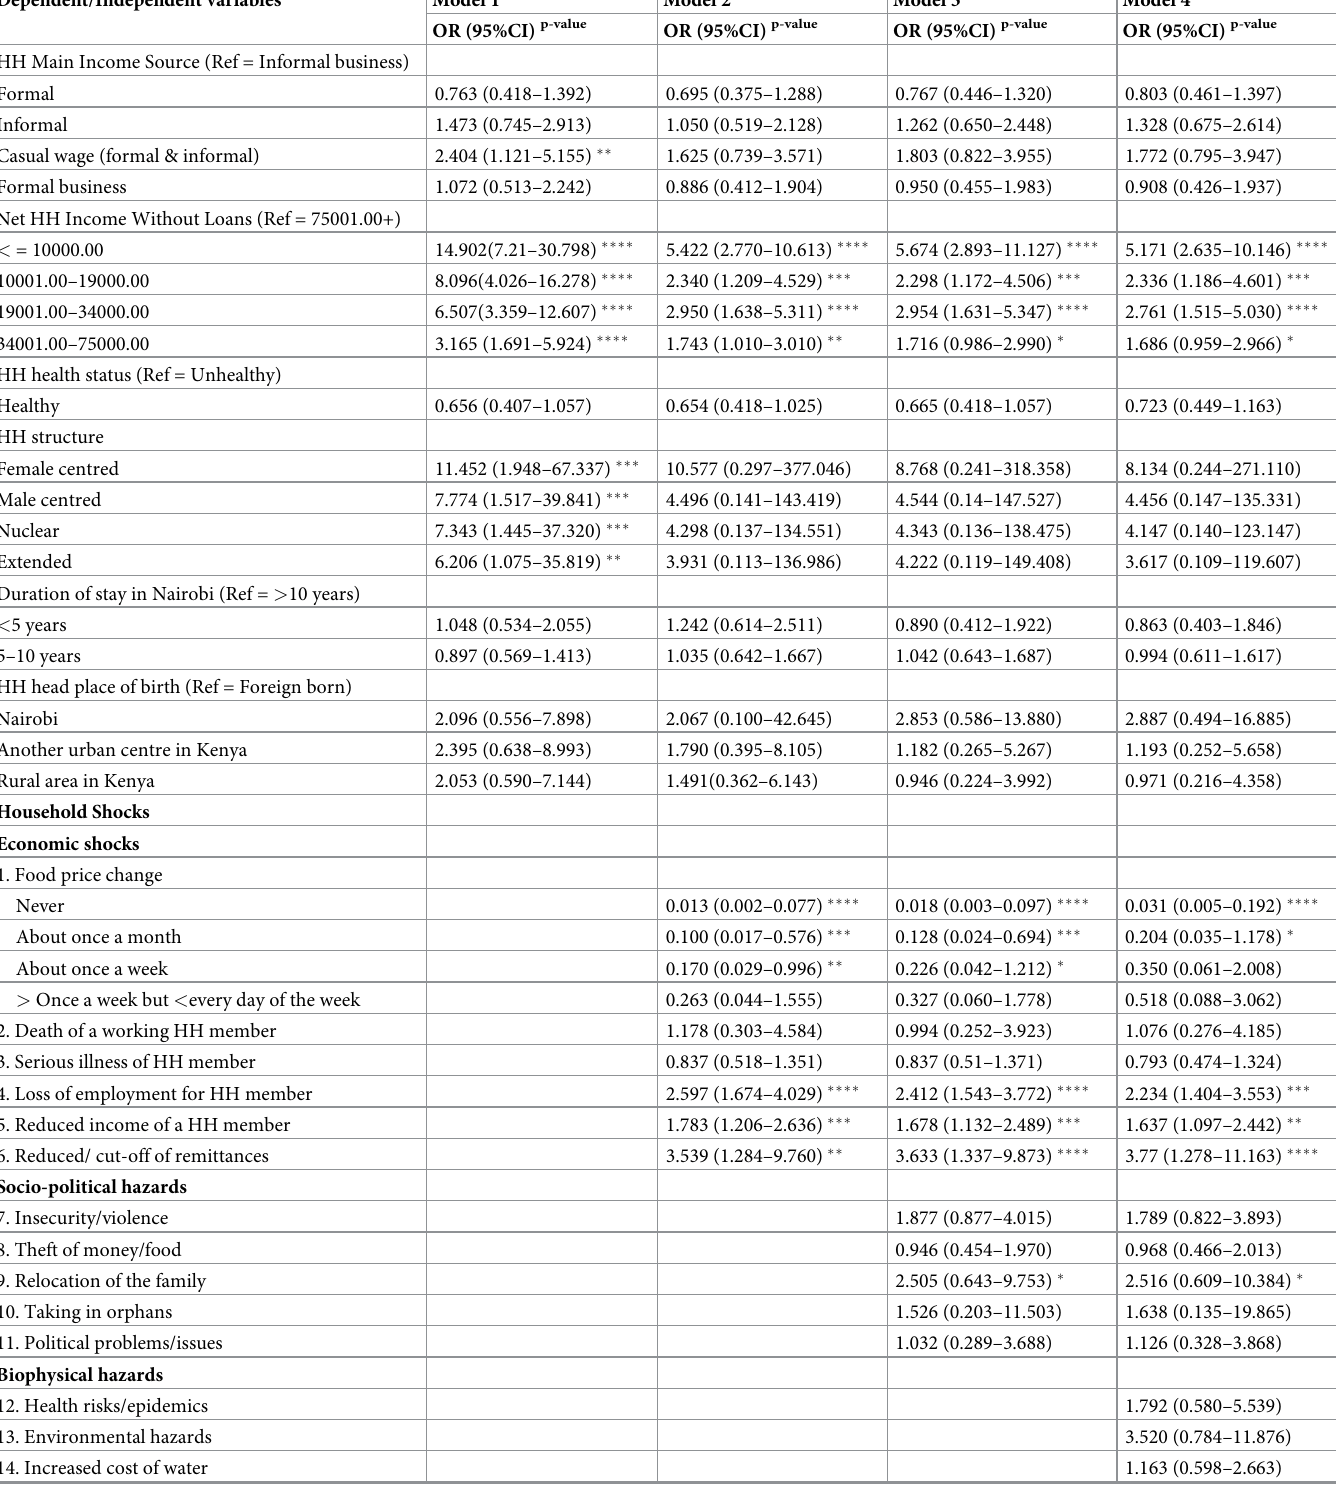
Table 5. Generalized linear mixed model of shocks to urban household food